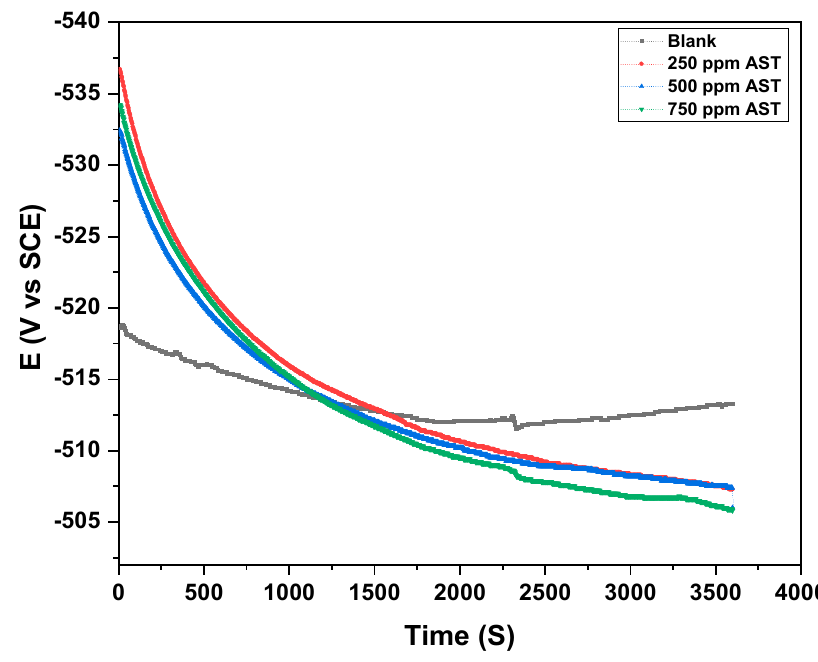
Figure 4. OCP for C1018 carbon steel in 1 M HCl with various concentrations of AST inhibitors.